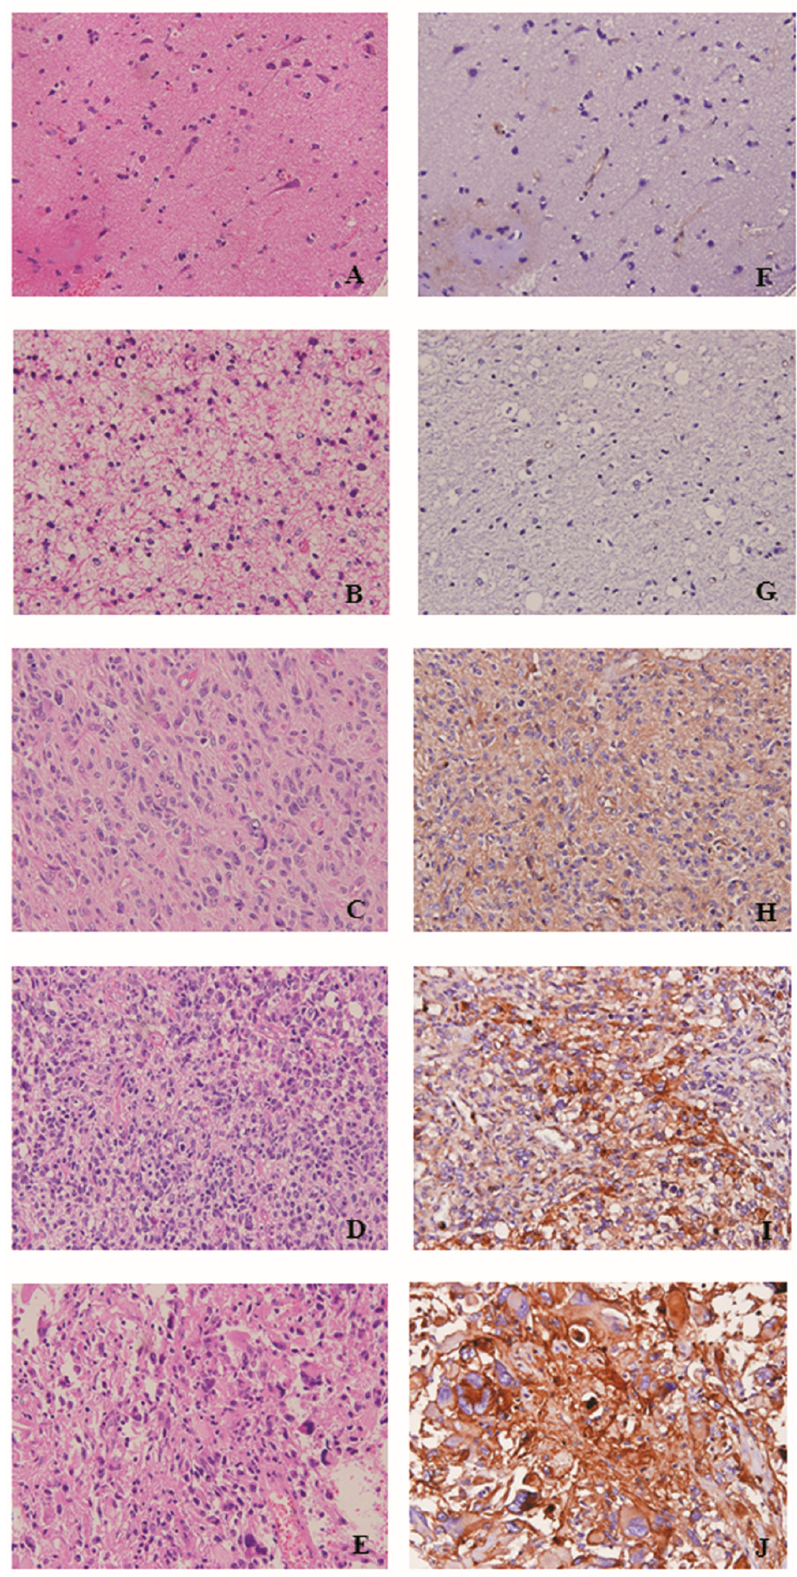
Figure 3. Hematoxylin and eosin staining of ( A ) normal brain tissue, ( B ) pilocytic astrocytoma, ( C ) diffuse astrocytoma, ( D ) anaplastic astrocytoma, and ( E ) glioblastome multiforme. IHC analysis of PLP2 in ( F ) normal brain tissue, ( G ) pilocytic astrocytoma, ( H ) diffuse astrocytoma, ( I ) anaplastic astrocytoma, and ( J ) glioblastoma. (Original magnification ×